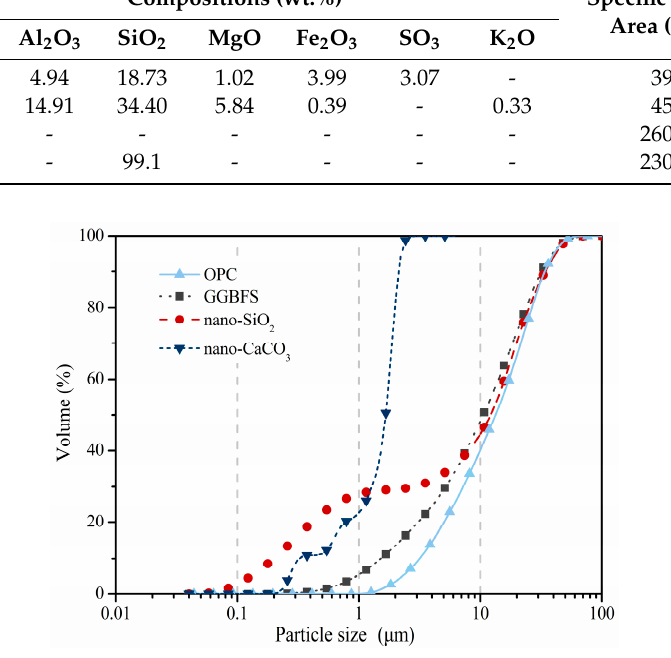
Figure 1. Particle size distribution of the applied materials.